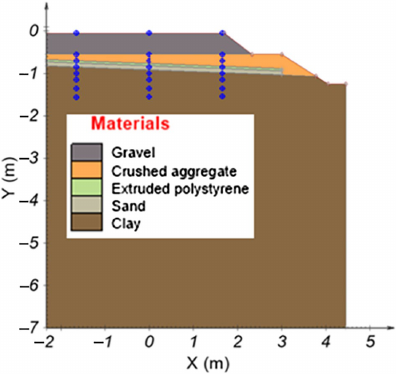
Figure 4. Numerical model – measuring profile no.